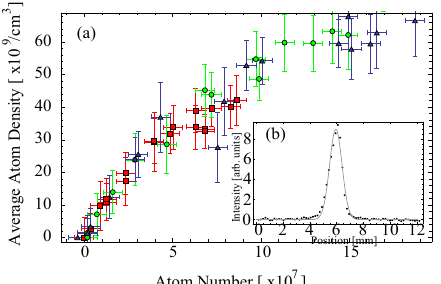
Figure 23. (Color online) ( a ) Variation in average density as a function of atom number. The atom number, inferred from trap fluorescence, was varied by changing the trap laser power. The trap laser detuning was fixed at 15 MHz below resonance, the trapping beam diameter was ∼ 0.90 cm and the magnetic field gradient was ∼ 7 G/cm. Three different repump laser powers were used, 0.60 ± 0.06 mW (red squares), 1.0 ± 0.1 mW (green circles), and 50 ± 5 mW (blue triangles). The cloud radius was determined from fits along two dimensions that were summed in quadrature. ( b ) Spatial profile of the cloud obtained from a CCD camera image for a trap laser power of 75 ± 7 mW, repump laser power of 50 ± 5 mW, and a magnetic field gradient of ∼ 7 G/cm. The vertical axis represents the intensity obtained by integrating pixel values. A Gaussian fit gives a 1/ e 2 cloud radius of 0.66 ± 0.01